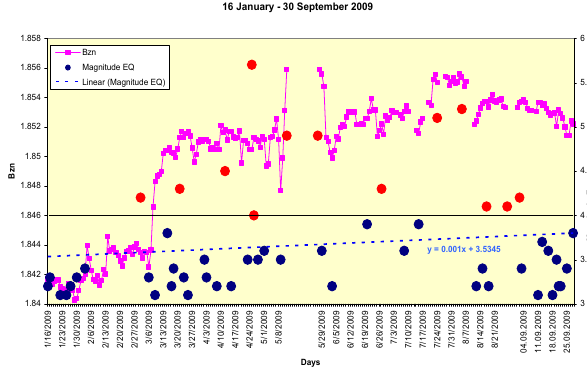
Fig.9 Fig. 9. Distributions of the Bzn and earthquake magnitude on the whole interval analysed; blue circles are earthquakes with M < 4 and red circles are earthquakes with M ≥ 4.